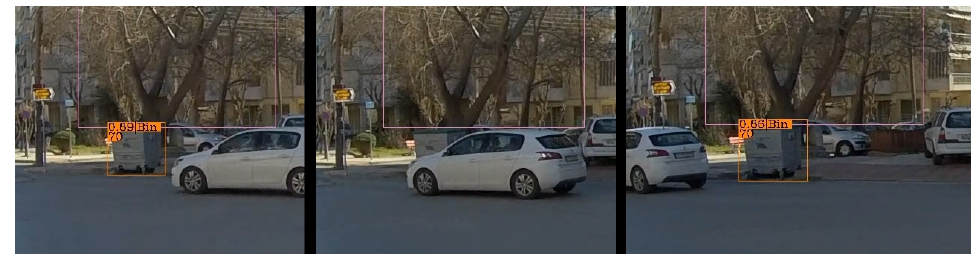
Figure 1. Object tracking example in consecutive